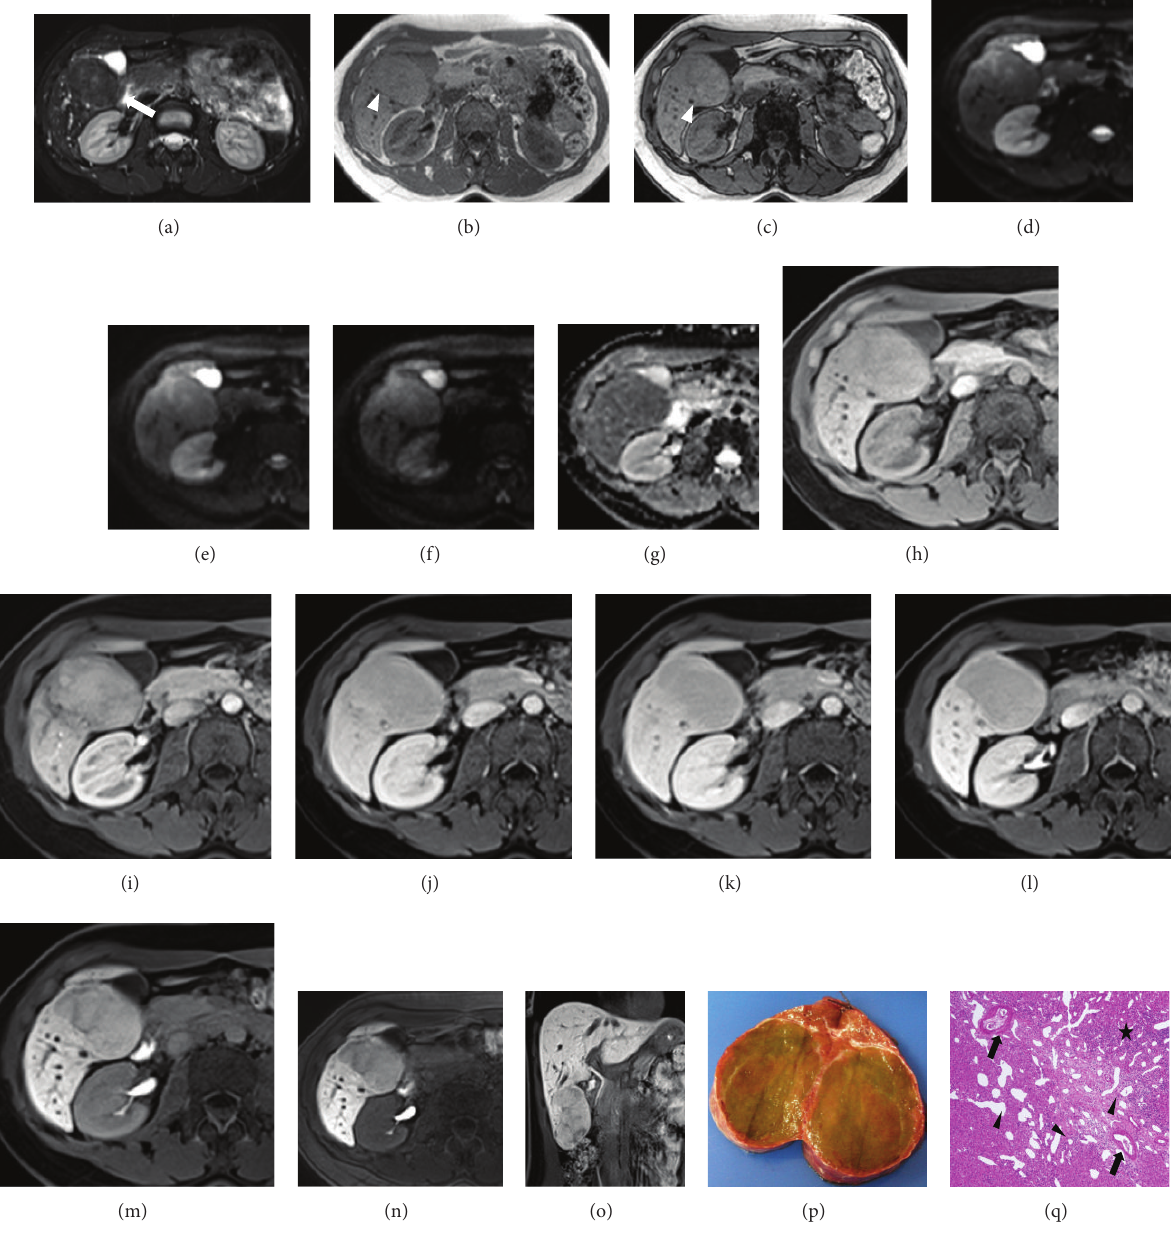
Figure 3: Atypical inflammatory adenoma. (a) In S VI homogeneous well-delineated isointense lesion in axial T2w fat-suppressed image (arrow). (b-c) T1w in- and out-phased images. The mass is isointense relative to the hepatic parenchyma. Note large vessels at the periphery of the lesion (arrowheads). (d–g) DWI sequences. The lesion does not show any increase of signal intensity from 50 (d) to 400 (e) and to 800 (f) b values. IN ADC map (g) the nodule shows isointense signal. (h–l) In dynamic evaluation after Gd-EOB-DTPA administration the mass shows discrete enhancement in arterial phase (i) with slightly wash out in portal (j) and equilibrium (k) phases. After 5 󸀠 (l) the nodule is more hypointense. (m-n) In hepatobiliary phases after 10 󸀠 (m) and 20 󸀠 (n), the lesion is definitively heterogeneously hypointense relative to the adjacent liver parenchyma with exophytic growth. (o) Cut section shows large capsulated homogeneous mass. (p) Microscopically, significant sinusoidal dilatation (arrowheads), polymorphous inflammatory infiltrates (star), areas of peliosis, and thickened tortuous arteries (arrow) are